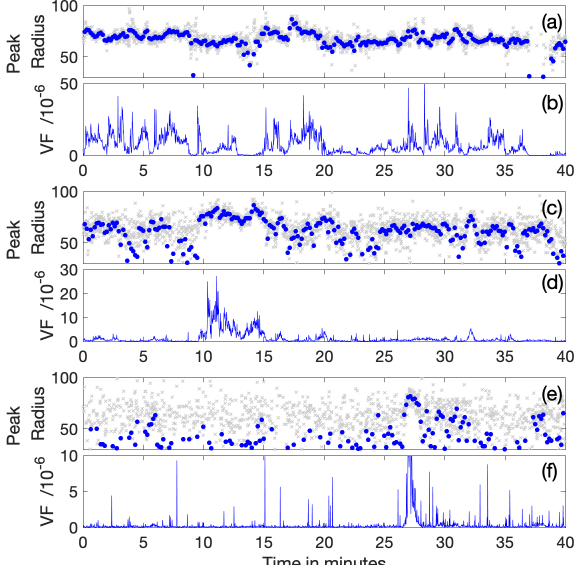
Figure 6. The variation in the fitted bubble radius (µm) at the volume peak at three wind speeds at 2m depth. Each pair shows void fraction below and peak volume radius above. The grey dots are 1s values and the dark blue are 10s averages. Panels (a) and (b) show data from 25 October starting at 1600, when wind speeds were 25–28ms − 1 and the mean void fraction was 6 . 8 × 10 − 6 . Pan- els (c) and (d) show data from 2 November when wind speeds were 16–18ms − 1 and the mean void fraction was 1 . 24 × 10 − 6 . Pan- els (e) and (f) show data from 1 November when the wind speeds were 10–12ms − 1 and the mean void fraction was 3 . 7 × 10 − 7 .